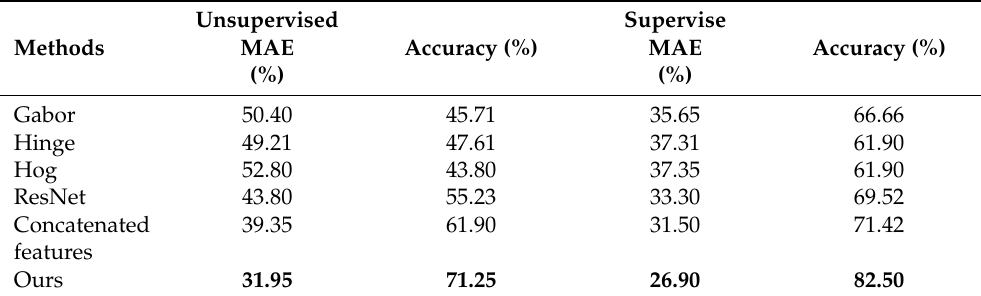
Table 2. Results of different feature extraction methods and the best results of our fusion approach on KERTAS dataset (test set). (Best values are highlighted in bold).